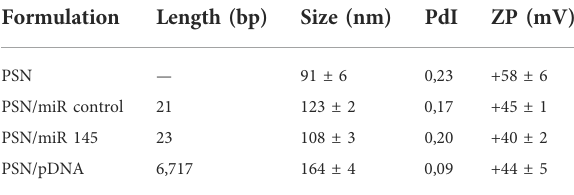
TABLE 2 Physicochemical characterization of PSN with and without different miR associated by DLS and LDA. Formulation